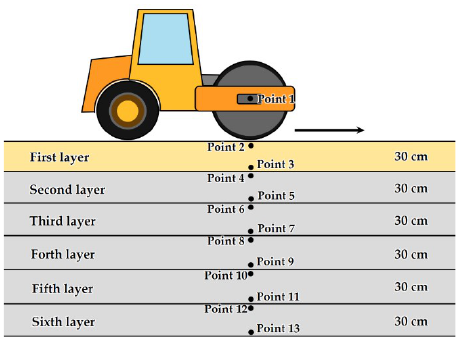
Figure 4. The distribution of the measurement points.